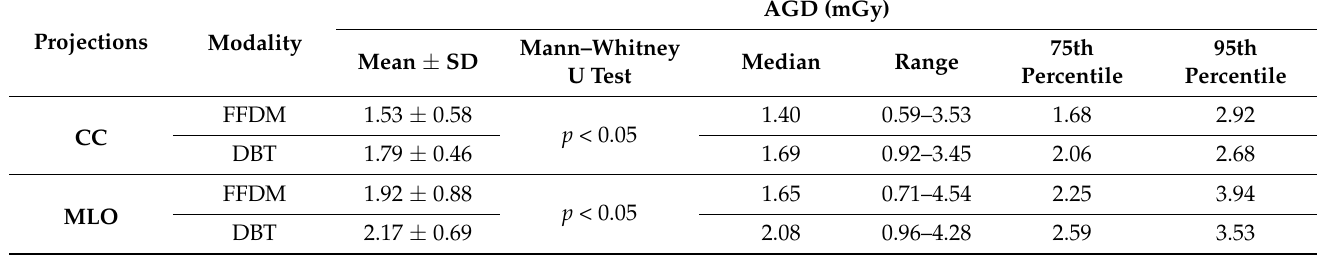
Table 5. Mean, median, range, 75th, and 95th percentiles of AGD for all mammographic projections in full-field digital mammography (FFDM) and digital breast tomosynthesis (DBT).